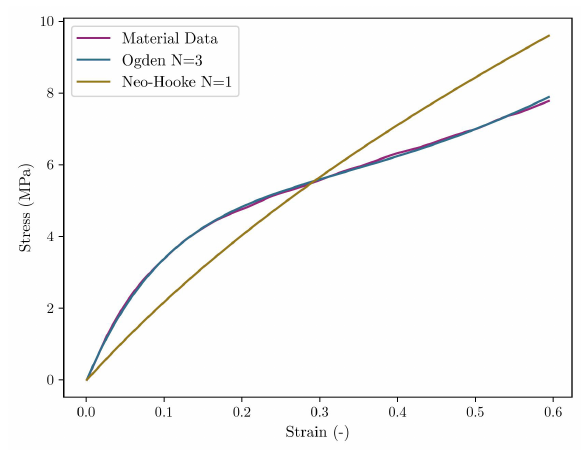
Figure 4. Material Model